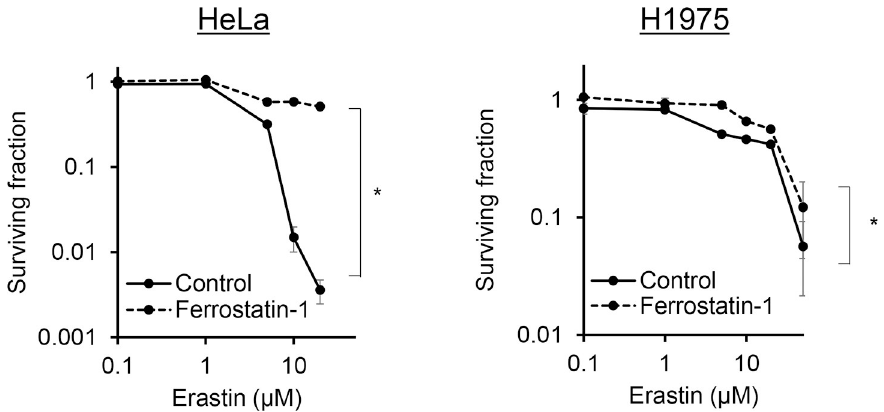
Fig 1. Ferrostatin-1 suppressed erastin cytotoxicity in human adenocarcinoma cell lines. Clonogenic assay of the HeLa and NCI-H1975 cells. The cells were treated with erastin alone or in combination with 1.0 μ M ferrostatin-1 for 24 h. All data are expressed as mean ± S.E. (n = 3, � p < 0.0001, two-way ANOVA).